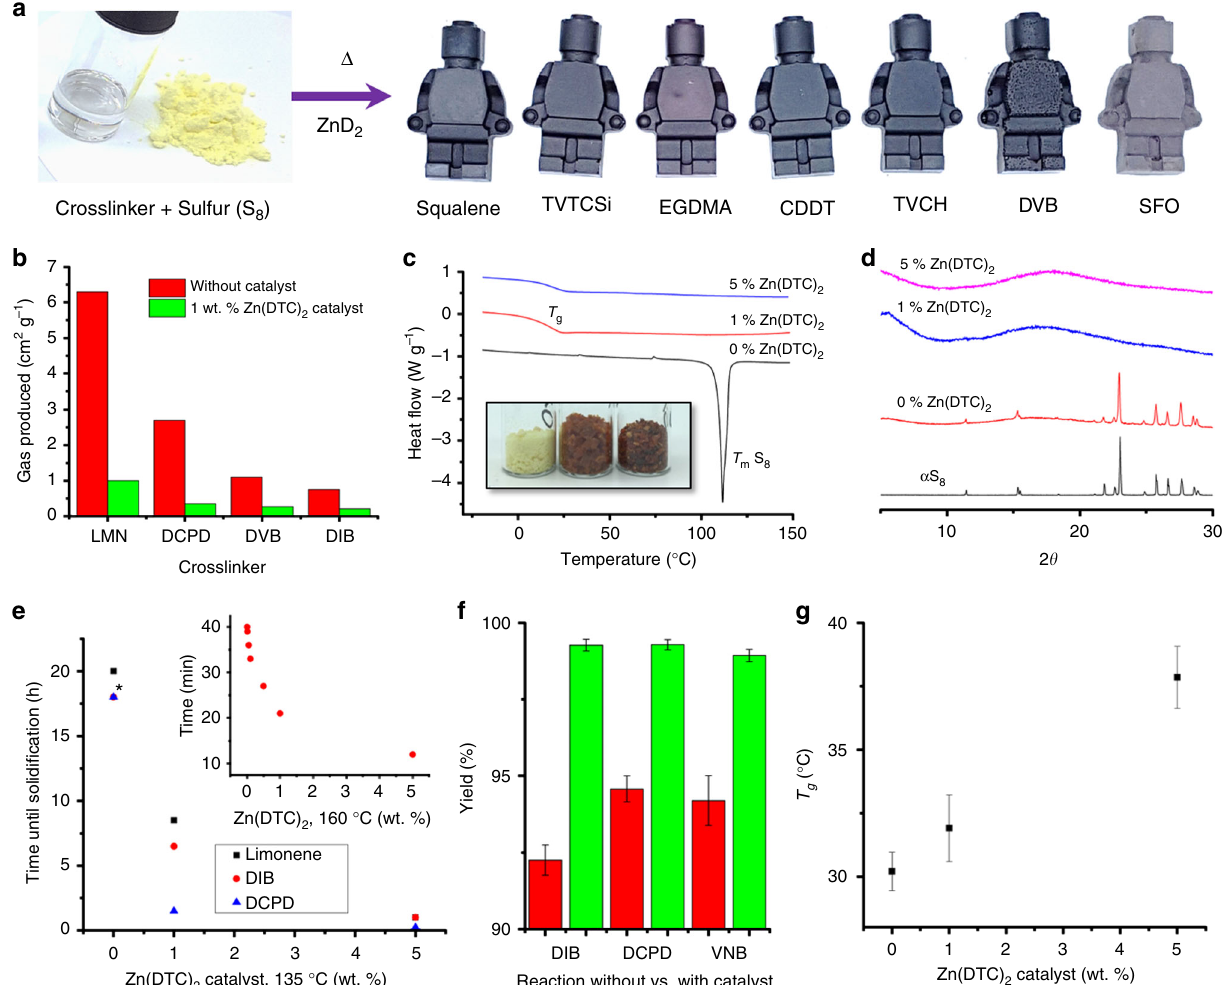
Fig. 2 Characterization of catalyzed thiopolymers. a Photographs of a crosslinker (EGDMA) and elemental sulfur and examples of molded objects of catalyzed thiopolymers. b Volume of gas produced during reactions of sulfur with crosslinkers, with (red) and without (green) catalysts. c Offset DSC traces of sulfur reacted with EGDMA. In the absence of catalyst, the melting of S 8 crystals at ~120 °C is apparent. Inset photograph shows the color of the products (from left to right: 0, 1, and 5 wt% catalyst). d Offset PXRD patterns of sulfur reacted with EGDMA, in the absence of catalyst the diffraction of S 8 crystals is apparent. e Reaction time plotted against catalyst loading at 135 °C. Asterisk (*) indicate uncatalyzed DIB and DCPD took between 12 and 24 h (unobserved), plotted as 18 h. f The yield of open reactions performed at 135 °C, with (red) or without (green) 1 wt% Zn(DTC) 2 catalyst. Error bars given for standard deviation of 3 repeats. g Glass transition temperature of insoluble sulfur-squalene polymers as a function of Zn(DTC) 2 catalyst loading,